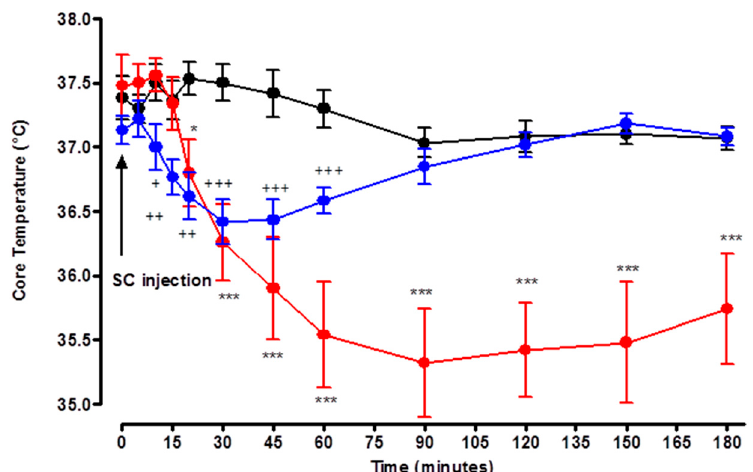
Figure 2. Effects of solvent (black circle), DMPO 50% median lethal dose (MLD50) (blue circle), and diethyl paraoxon (DEPO) 50% MLD50 (red circle) on core temperature. Arrow denotes the time of injection of solvent, DMPO or DEPO. Each group consisted of six rats. Data are represented by mean ± SEM at each time after injection. DMPO vs. control: + p < 0.05, ++ p < 0.01, and +++ p < 0.001. DEPO vs. control: * p < 0.05, ** p < 0.01, and *** p < 0.001.